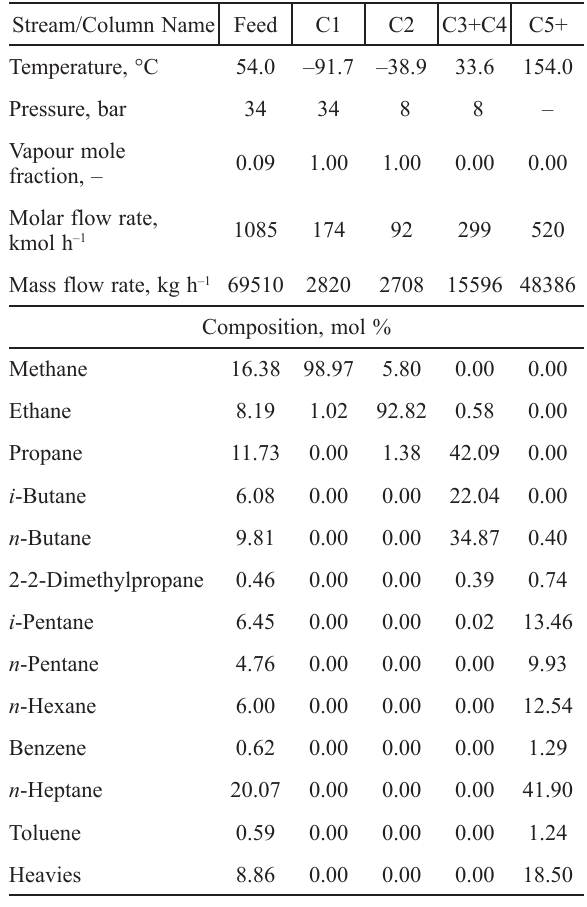
Table 1 – Feed and product specifications for NGL fraction- ation in a LNG